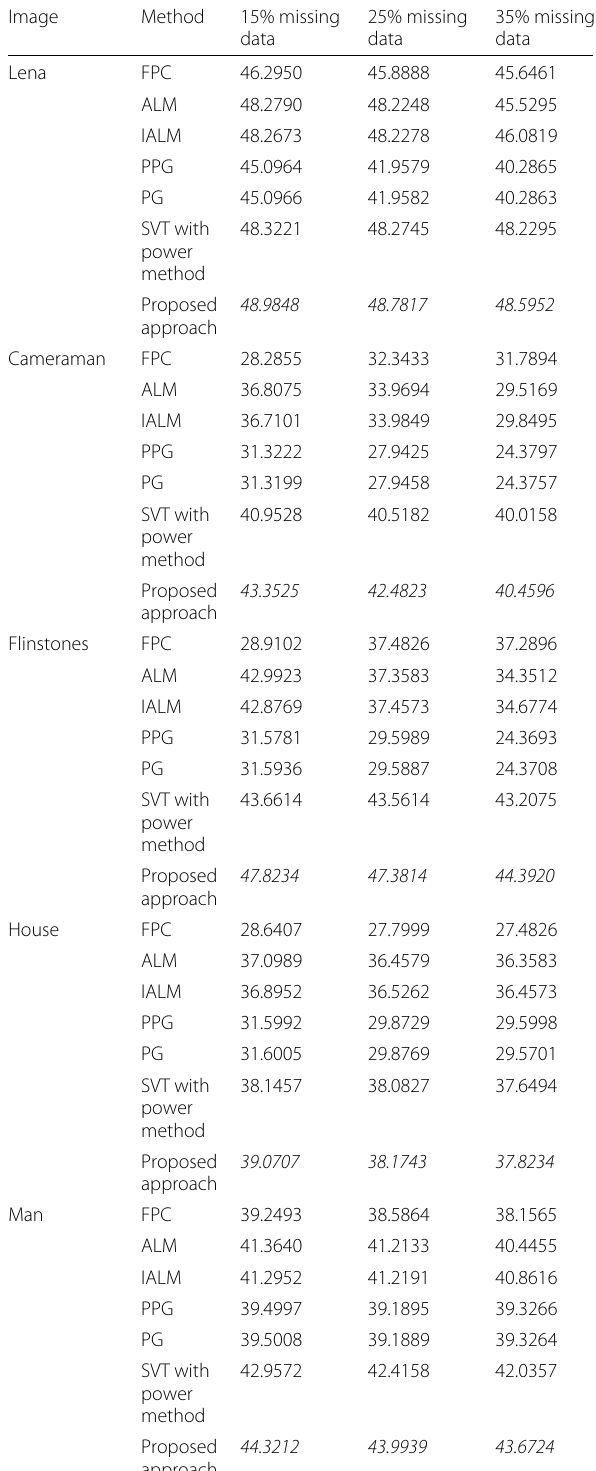
Table 1 PSNR values of the reconstructed images using different